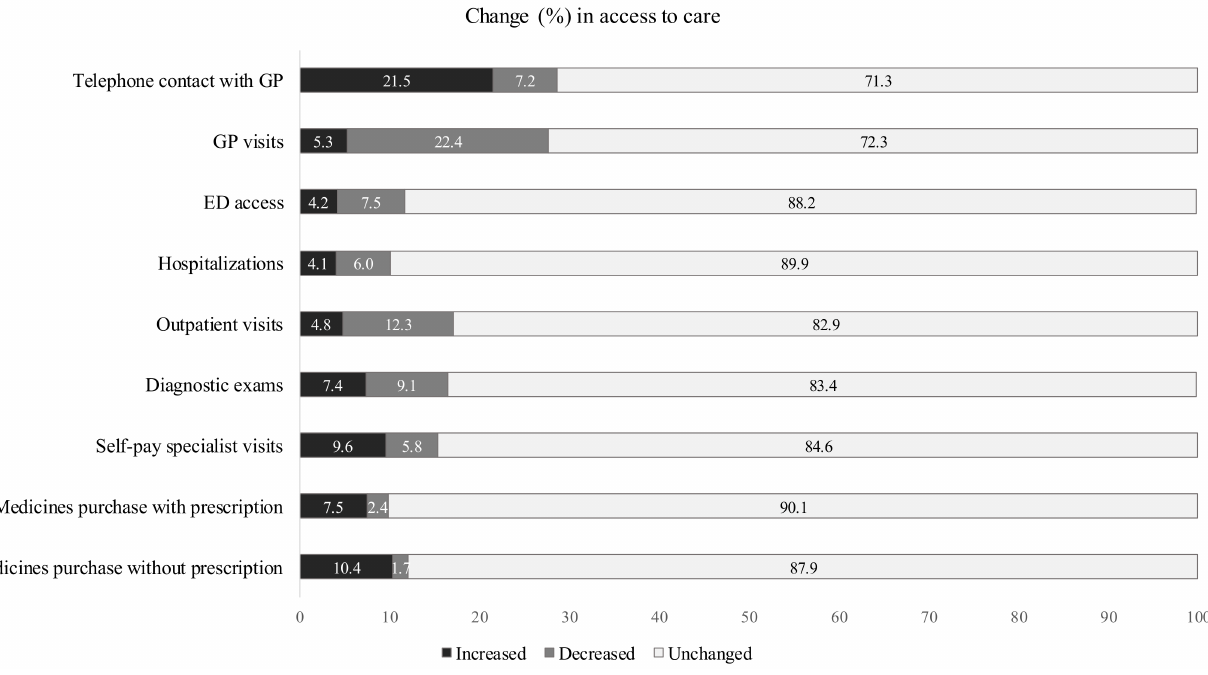
Figure 1. Proportions of change in access to care in the overall study population ( n = 4400). GP: general practitioner; ED: emergency